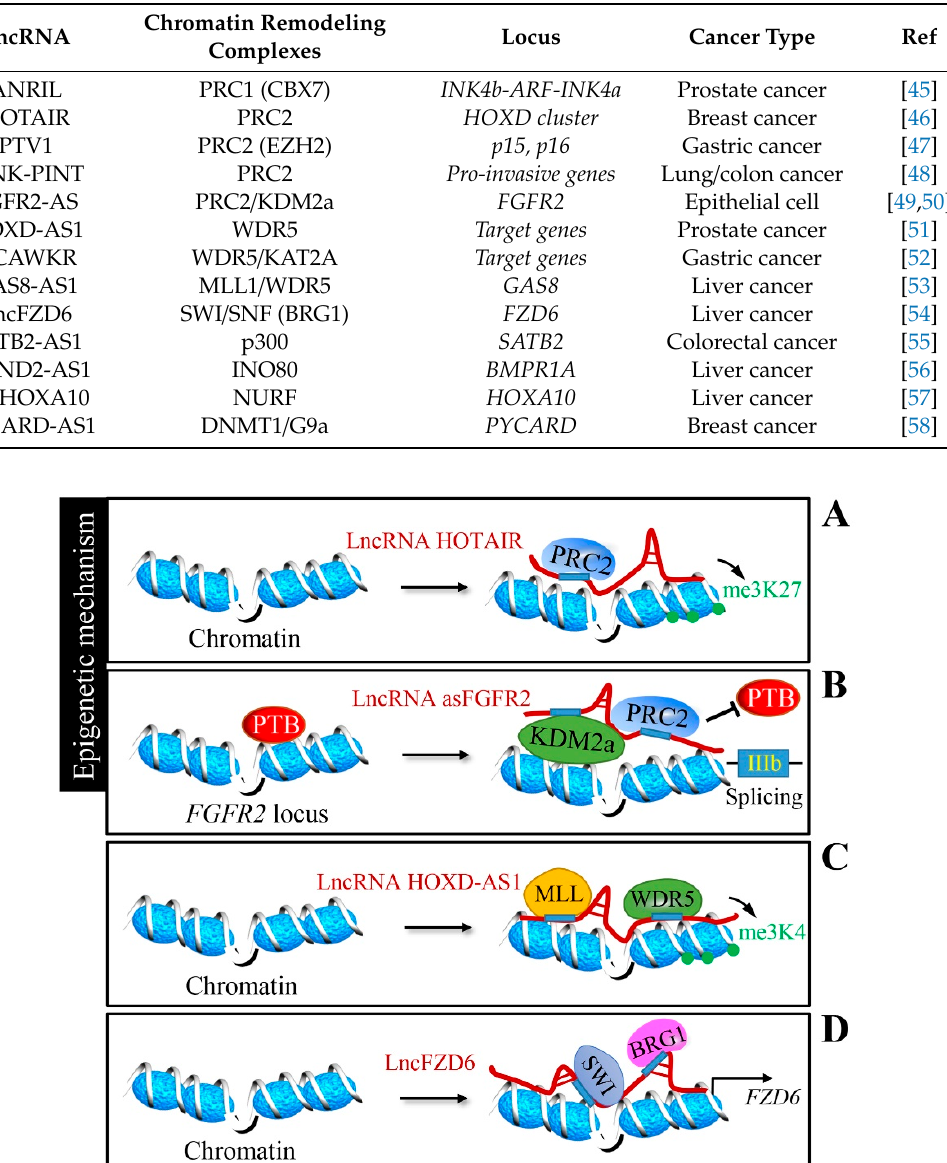
Figure 2. Epigenetic regulation by lncRNAs. ( A ) LncRNA HOX transcript antisense intergenic RNA (HOTAIR) regulates HOXD cluster genes via the recruitment of the polycomb repressive complex 2 (PRC2) silencing complex to execute gene silencing by histone H3 lysine 27 tri-methylation (H3K27me3). ( B ) LncRNA FGFR2-AS recruits the PRC2 complex and histone demethylase KDM2a to the FGFR2 locus, generating a splicing-specific chromatin signature. ( C ) LncRNA HOXD antisense growth-associated long non-coding RNA (HOXD-AS1) recruits the WD repeat domain 5 (WDR5)-mixed-lineage leukemia (MLL) complex and mediates histone H3 lysine 4 tri-methylation (H3K4me3) to directly regulate the expression of target genes. ( D ) Divergent lncRNA of FZD6 (LncFZD6) recruits the BRG1-embedded SWI/SNF complex to the FZD6 promoter and drives FZD6 transcription.